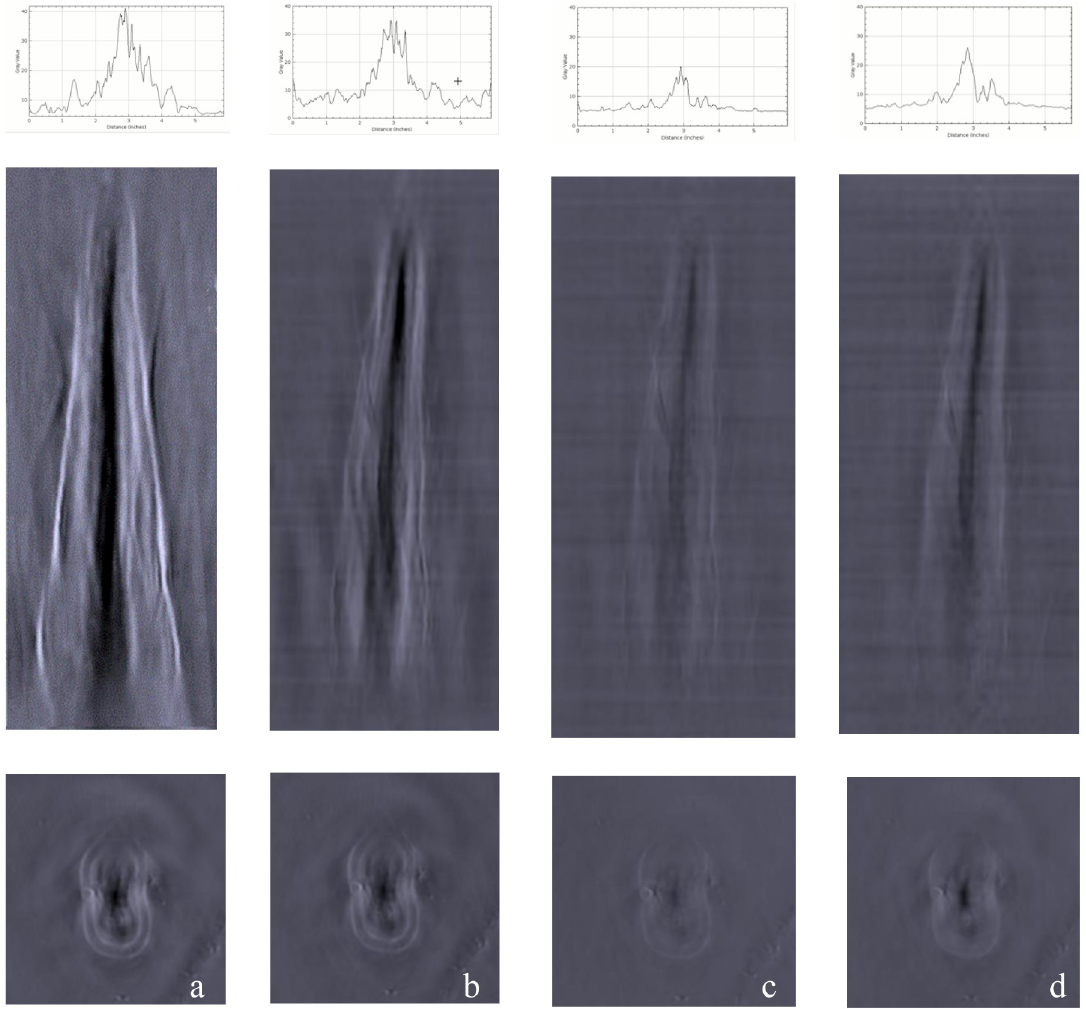
Fig 5. Comparison of photoacoustic images of the same human mandibular incisor recorded with different wavelengths. The analysis of the grey-scale distribution with respect to the longitudinal sections are given in the graphs. The images show the longitudinal and transverse section of the incisor. (a) 680 nm, (b) 700 nm, (c) 800 nm, (d) 900